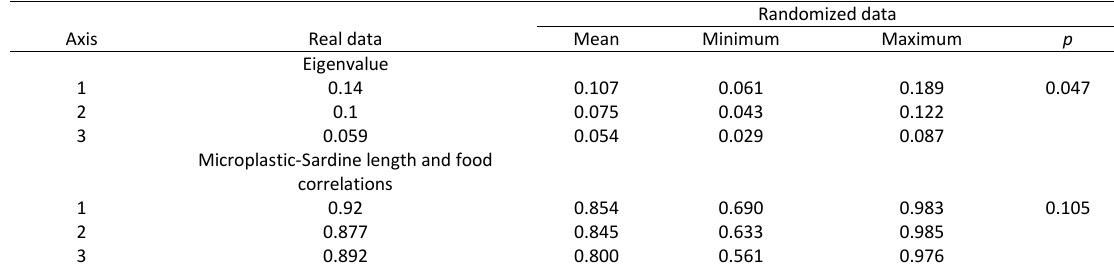
Table 6. Monte Carlo test results for eigenvalues and species-environment correlations based on 999 runs with randomized data